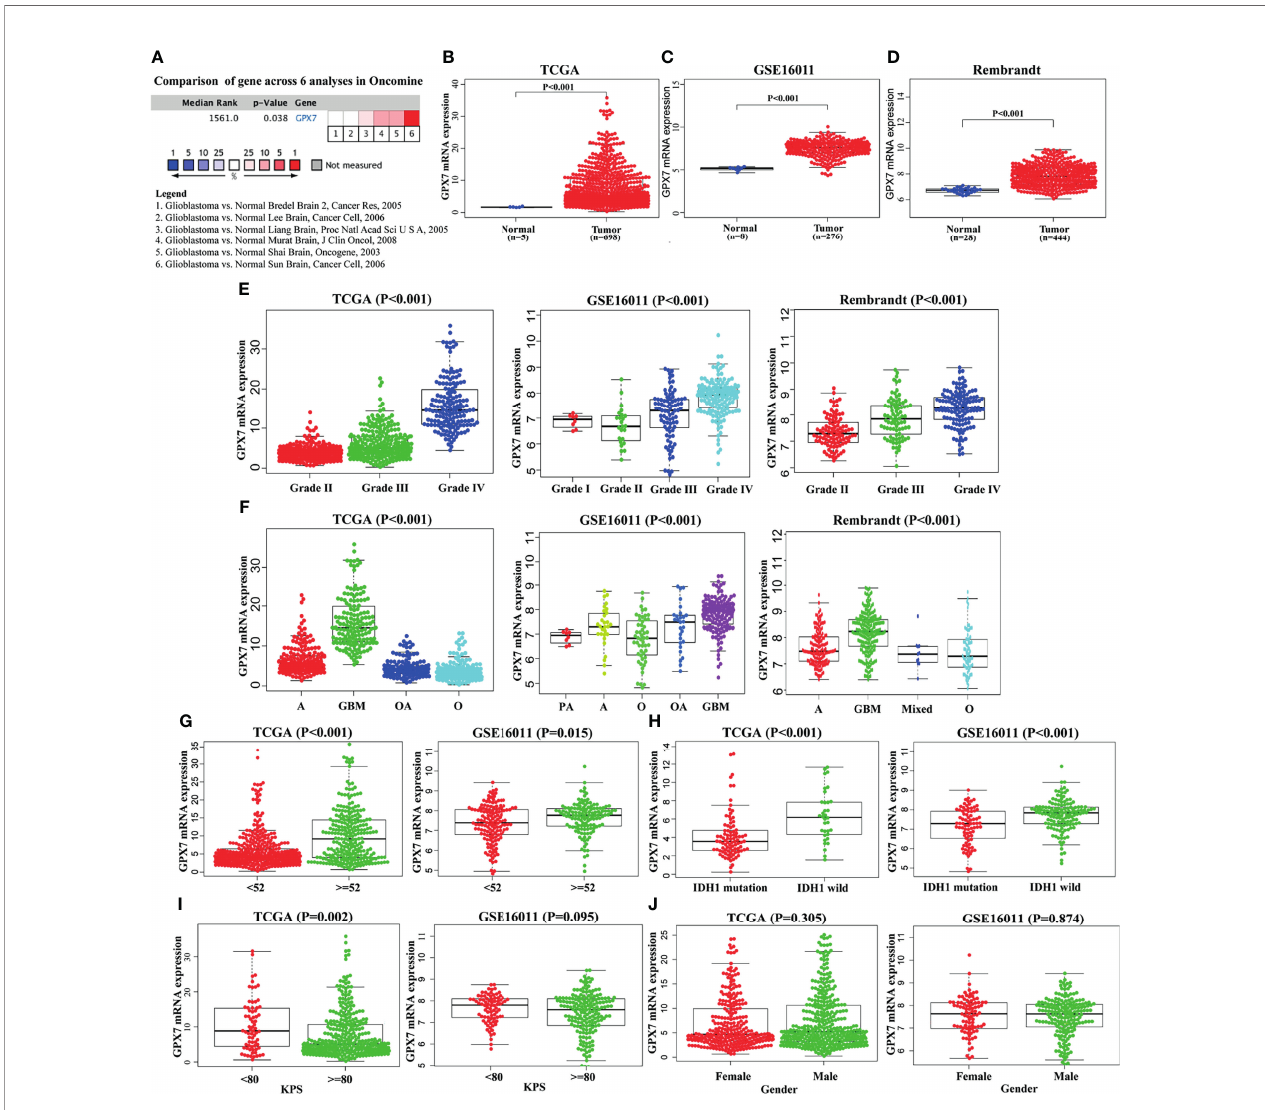
FIGURE 1 | The expression of GPX7 among databases. (A) The expression differences of GPX7 between normal and GBM were analyzed across the six analyses in Oncomine database. (B – D) The expression differences of GPX7 between normal and GBM in TCGA, GSE16011 and Rembrandt datasets. (E – J) The relationships between GPX7 and clinical characteristics among different